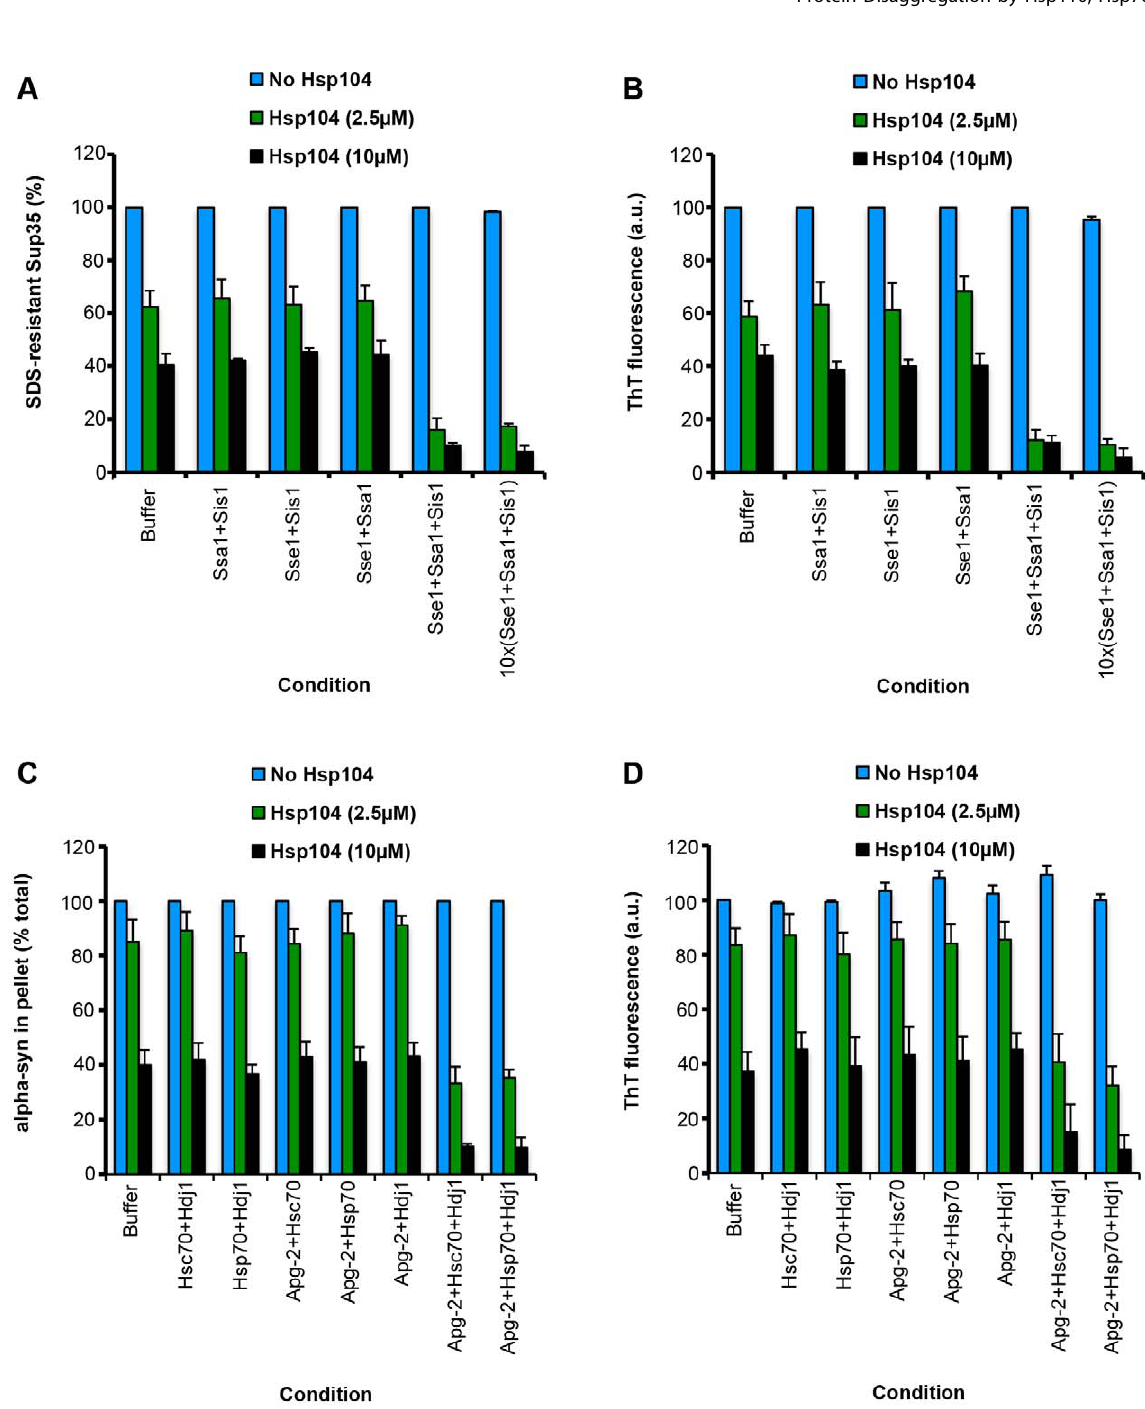
Figure 5. Pure Hsp110, Hsp70 and Hsp40 enhance Hsp104 disaggregase activity against Sup35 prions and a -syn amyloid fibers. ( A, B ) Preformed Sup35 prions (2 m M monomer) were incubated for 6 h at 25 u C in buffer plus ATP (5 mM) and ATP-regeneration system without or with the indicated combination of Ssa1 (2 m M), Sis1 (2 m M), Sse1 (2 m M) (each individual combination is an individual category of the x-axis) in the absence (blue bars) or presence of Hsp104 (0.5 m M, green bars; or 2 m M, black bars). For the 10x(Sse1 + Ssa1 + Sis1) condition the concentration of Ssa1, Sis1 and Sse1 was increased to 20 m M. Sup35 prion disassembly was assessed by the amount of SDS-resistant Sup35 ( A ) or by ThT fluorescence ( B ). Values represent means 6 SEM (n=3). ( C, D ) Preformed amyloid fibers composed of a -syn (0.5 m M monomer) were incubated for 6 h at 37 u C in buffer plus ATP (5 mM) and ATP-regeneration system without or with the indicated combination of Hsc70 (10 m M), Hdj1 (10 m M), Hsp70 (10 m M) and Apg-2 (10 m M) (each individual combination is an individual category of the x-axis) in the absence (blue bars) or presence of Hsp104 (2.5 m M, green bars; or 10 m M, black bars). Fiber integrity was then determined by sedimentation analysis ( C ) or by ThT fluorescence ( D ). Values represent means 6 SEM